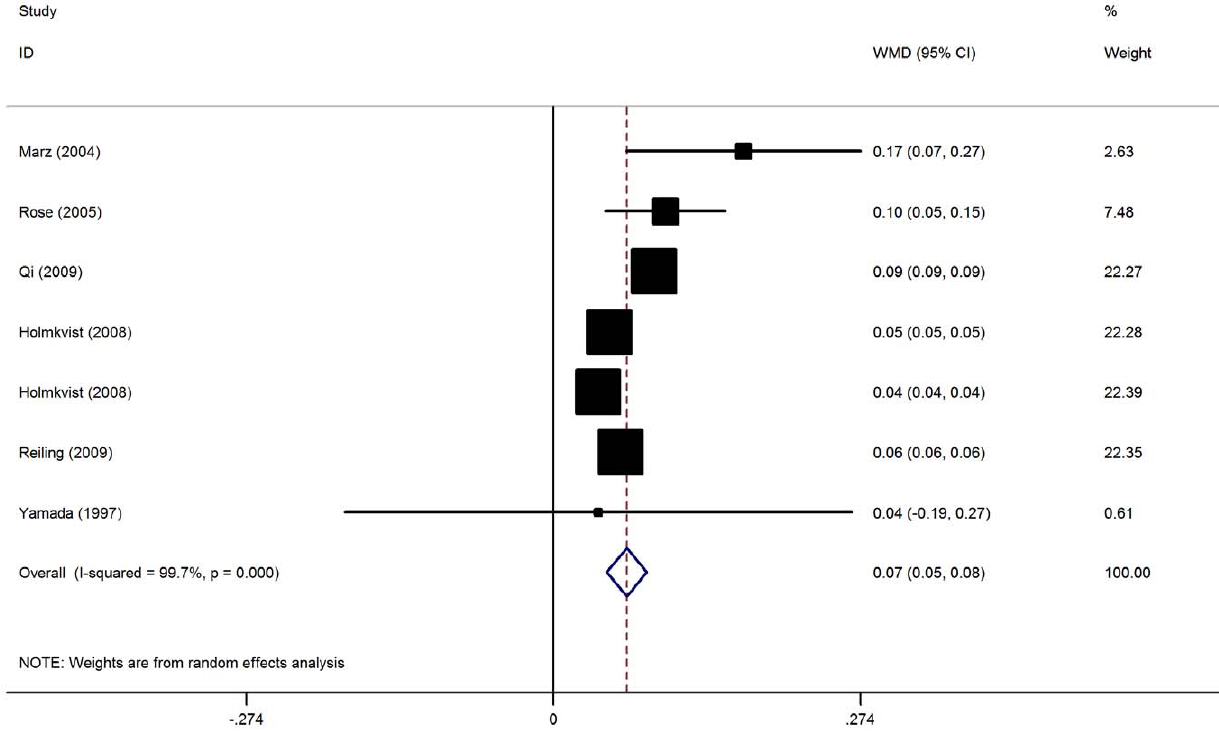
Figure 3. Meta-analysis of weighted mean differences (WMD) of fasting plasma glucose levels between GG and GA genotype of 2 30G . A polymorphism.